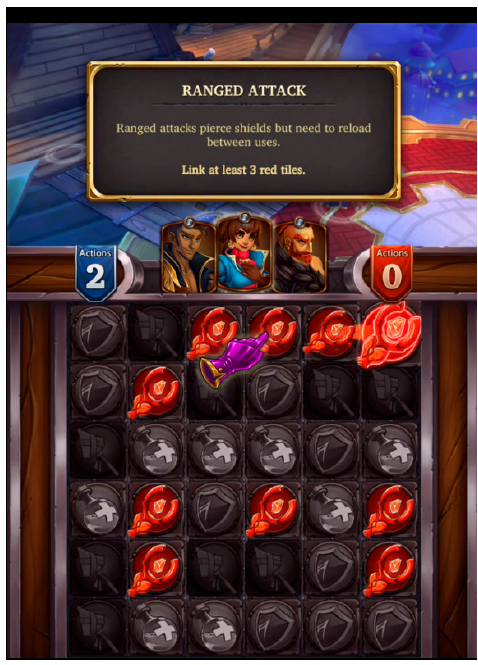
Figure 3. Example of a tutorial message with floating purple glove.